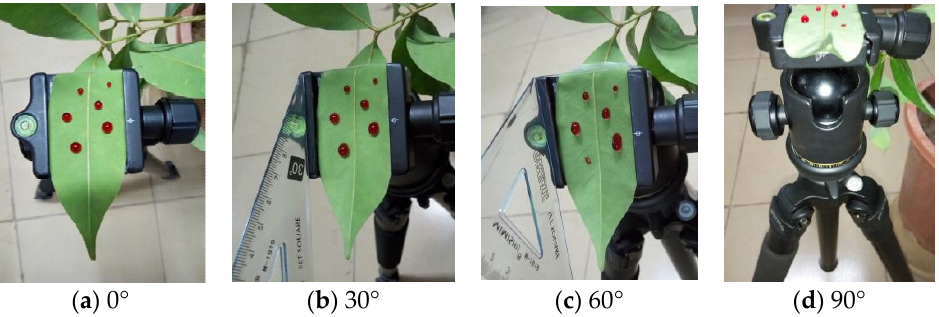
Figure 3. Measurement of the droplet deposition status and angle of the target-leaf surface; (a) Leaf inclination is 0°; (b) Leaf inclination is 30°; (c) Leaf inclination is 60°; (d) Leaf inclination is